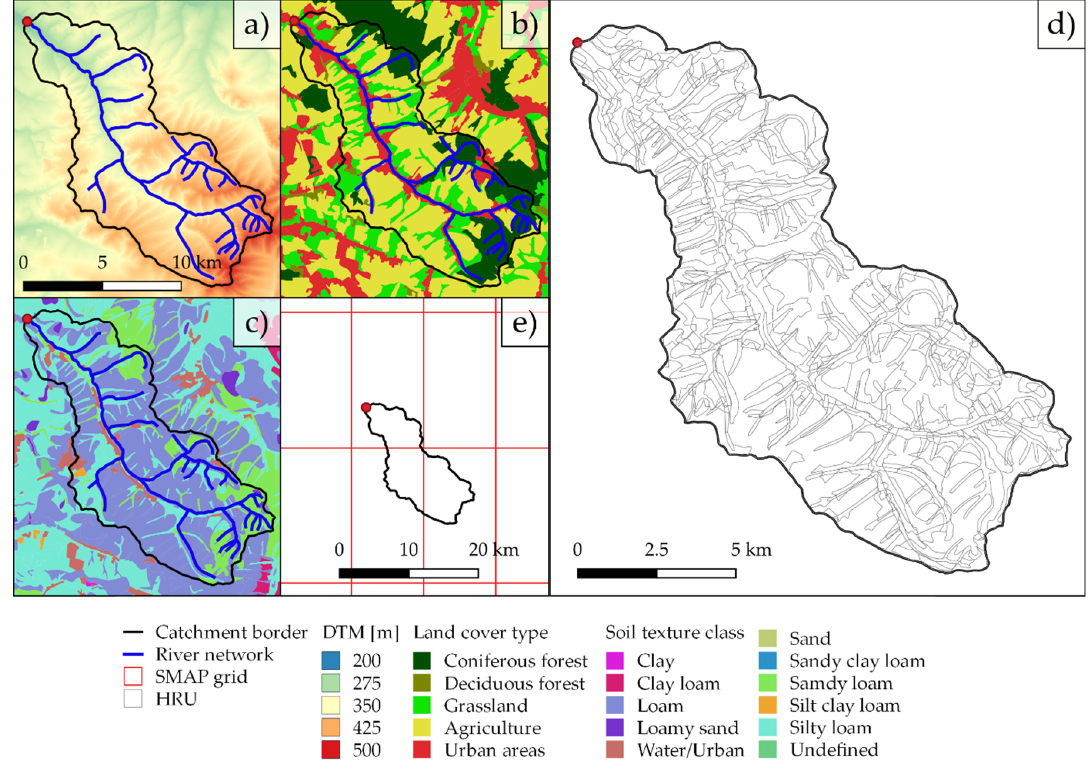
Figure 3. An overview of the input datasets (WG-S 84 projection), exemplary for the Niedermuelsen catchment: ( a ) digital elevation model (DEM) based on 10 m, ( b ) land use map simplified from CORINE 2012, ( c ) soil map converted from USDA soil classes and simplified from BK50, ( d ) hydro response units (HRUs): intersecting between simplified CORINE and BK50 and ( e ) SMAP_L4_GPH grid tiles.